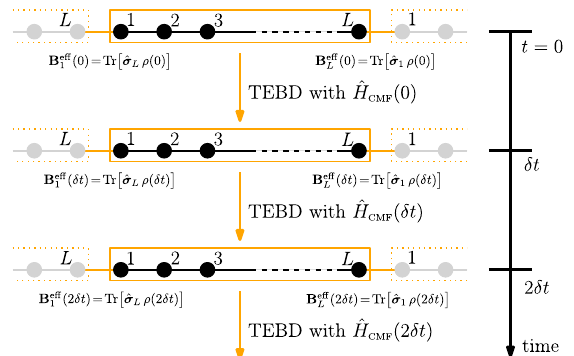
FIG. 4. One-dimensional TEBD scheme for 1D systems with open boundaries, combined with the cluster mean-field method. Circles denote the sites of the lattice. The many-body state corresponding to the OBC cluster made up of L black circles inside the orange box is written in a MPO representation and evolved in time with the TEBD scheme. The cluster is coupled to the rest of the system (gray circles) through the mean field at the edges. At regular small time intervals, the mean fields B eff 1 ð t Þ ¼ Tr ½ ˆ σ L ρ ð t Þ(cid:2) on the leftmost site and B eff L ð t Þ ¼ Tr ½ ˆ σ 1 ρ ð t Þ(cid:2) on the rightmost site are self-consistently evaluated and used to con- struct the Hamiltonian for the next TEBD